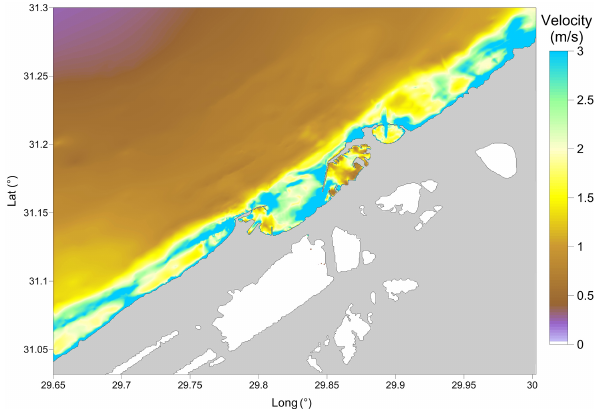
Figure 14. Water depth maxima on land for the CA case plotted in grid 4 (40m resolution) in mean-sea-level conditions. See caption of Fig. 6 for further details.